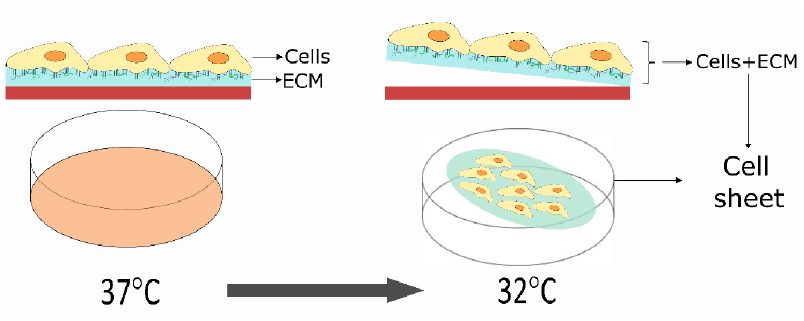
Figure 1. Schematic drawing of cell sheet harvesting.